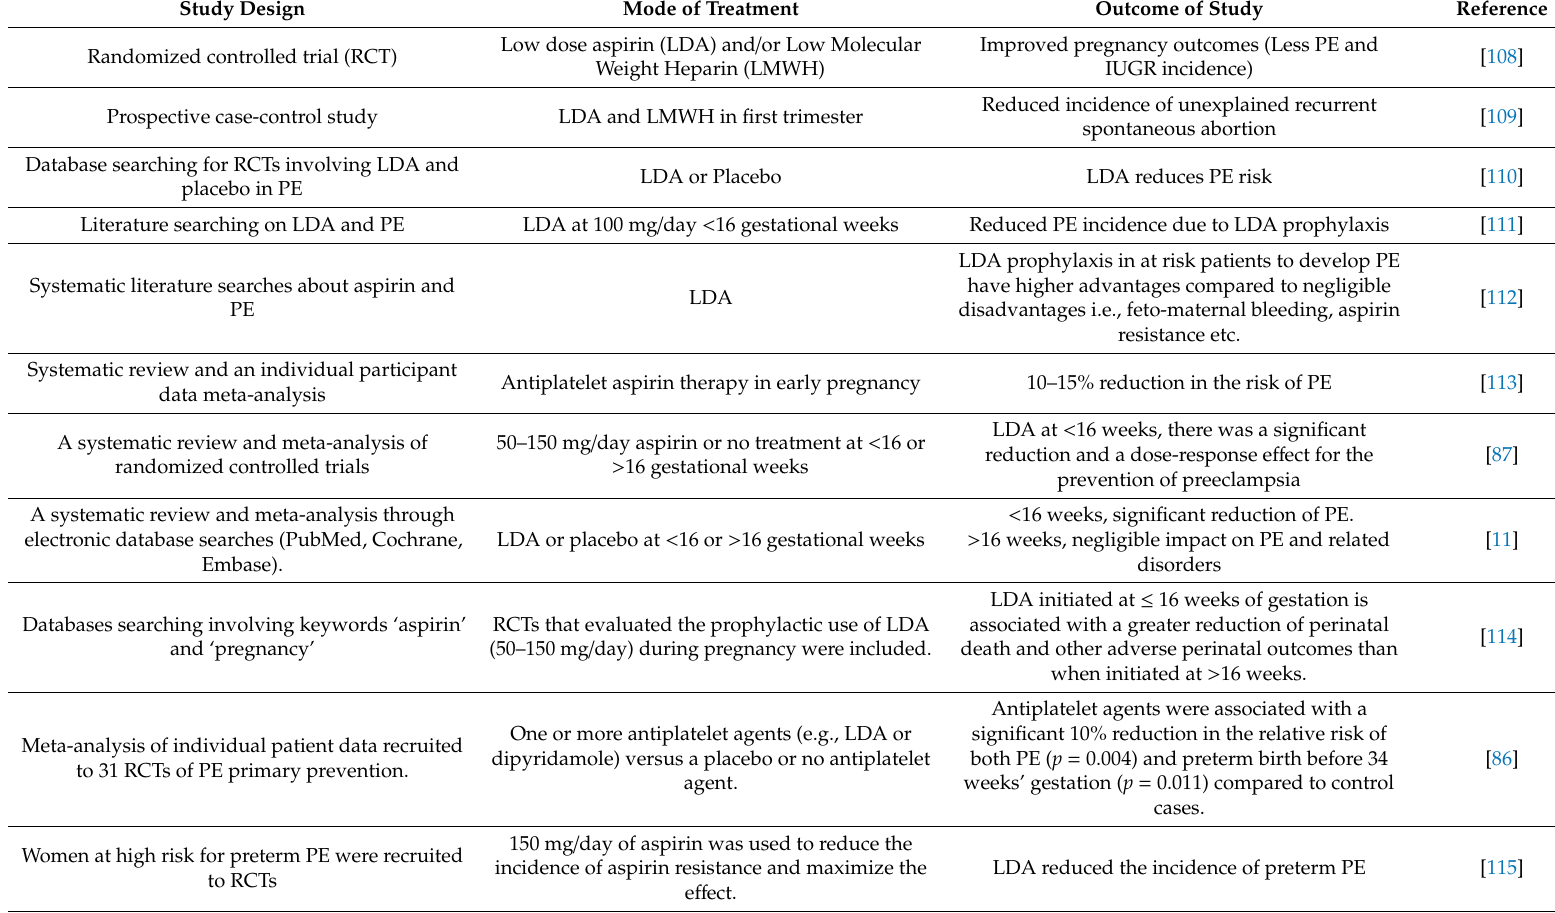
Table 1. Recent Studies on Aspirin and